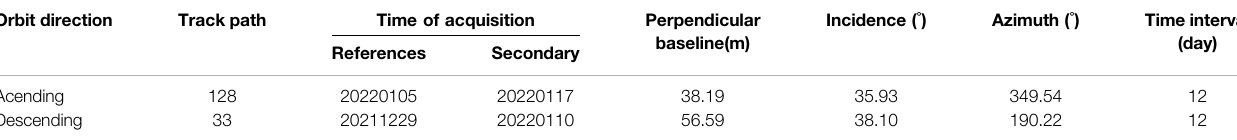
TABLE 1 | Basic parameters of the SAR data. Orbit